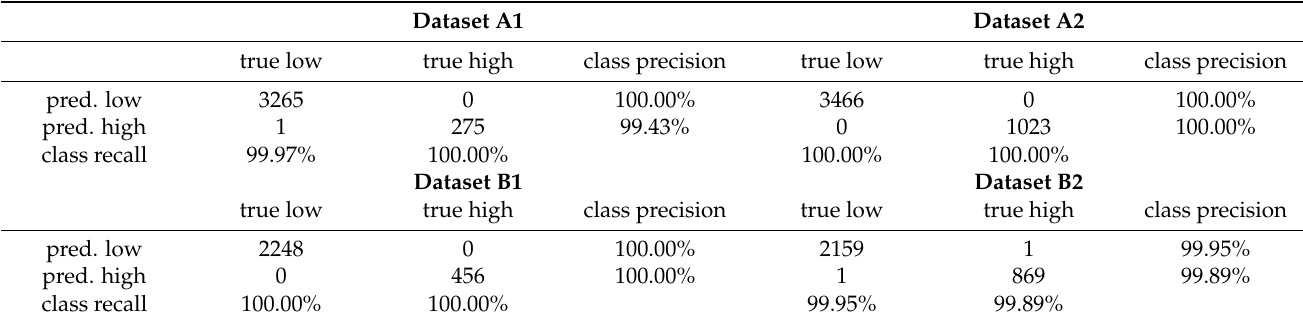
Table 5. Confusion matrix with the classification generated using RF. This table shows the classification obtained with labels “low” and “high”, using datasets A1, A2, B1, and B2. Table 5 also shows the accuracy, recall, and class-precision values for both